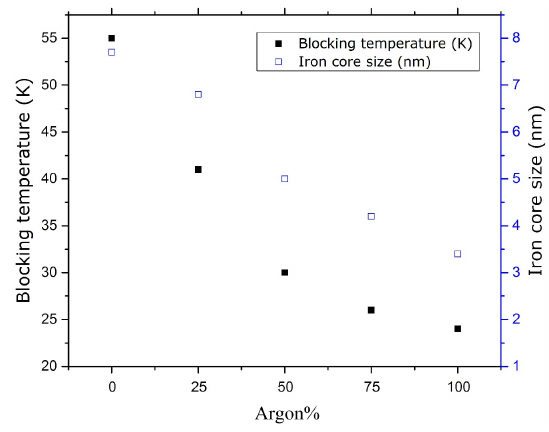
Figure 8. Dependency of iron core size and blocking temperature versus argon percentage.